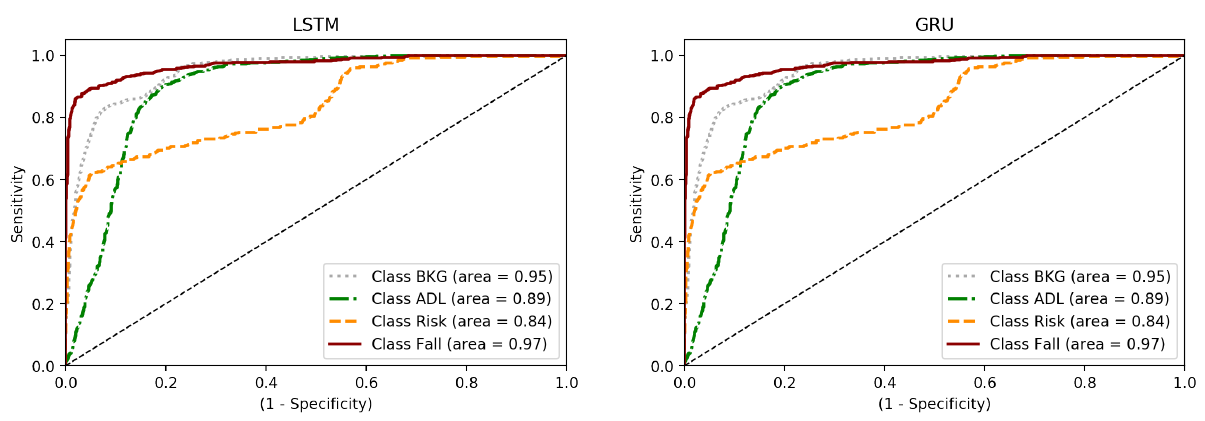
Figure 9. ROC curves for best LSTM and GRU